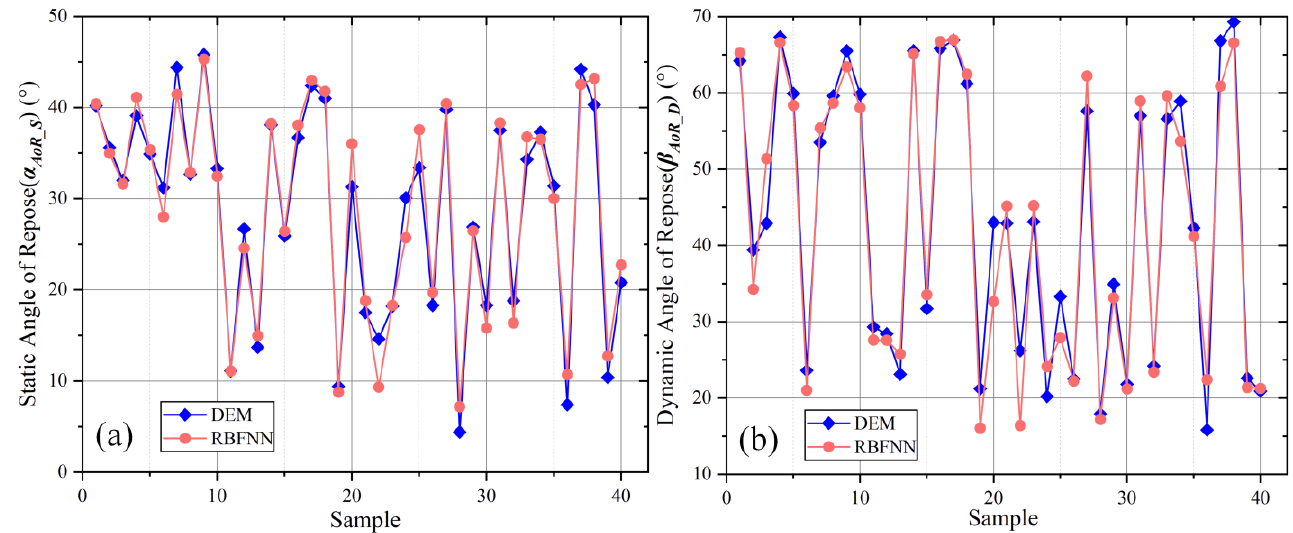
Figure 12. Relative error between RBFNN predicted and DEM simulated values: ( a ) α AoR_S ; ( b ) β AoR_D .